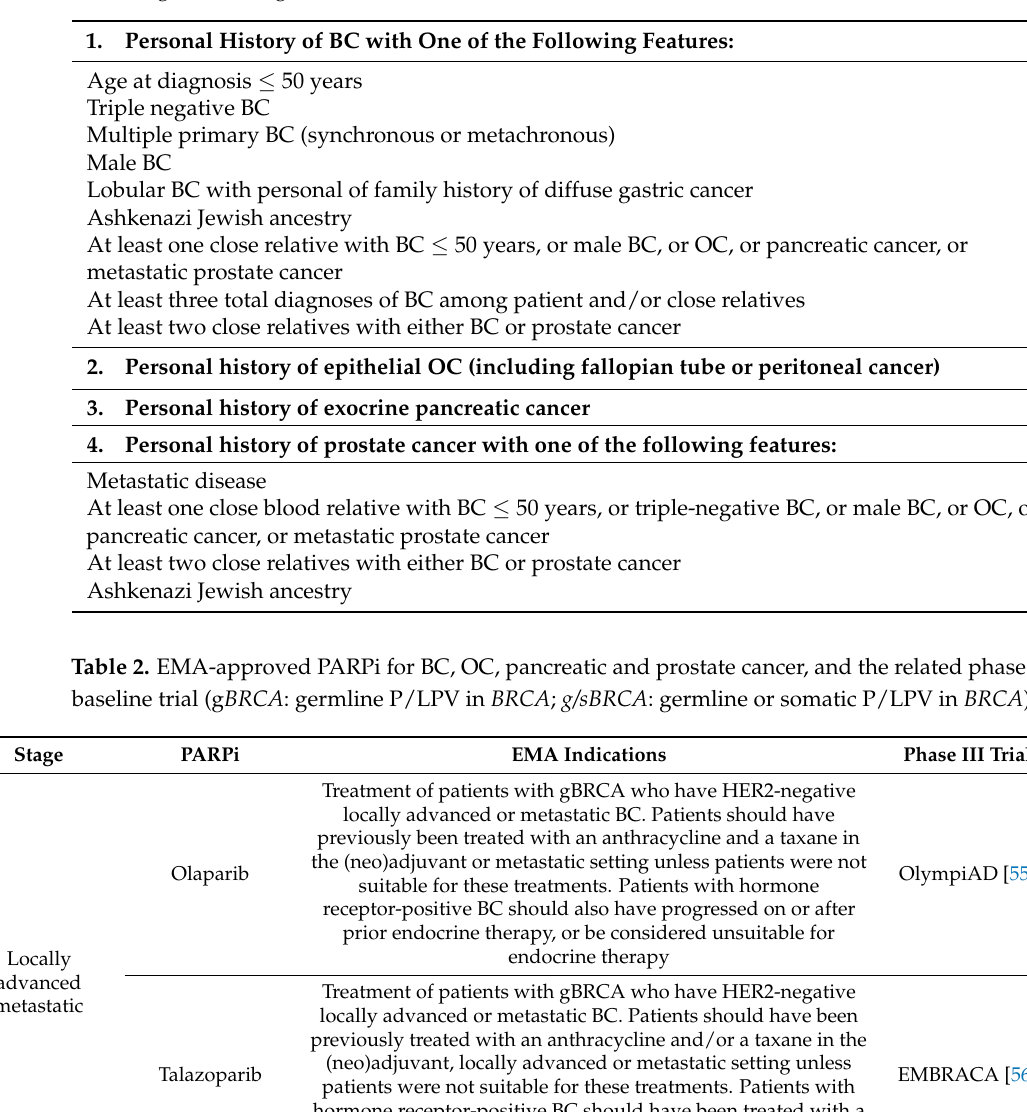
Table 1. Major testing criteria for breast, ovarian, pancreatic, or prostate cancer susceptibility genes according to NCCN guidelines [5].